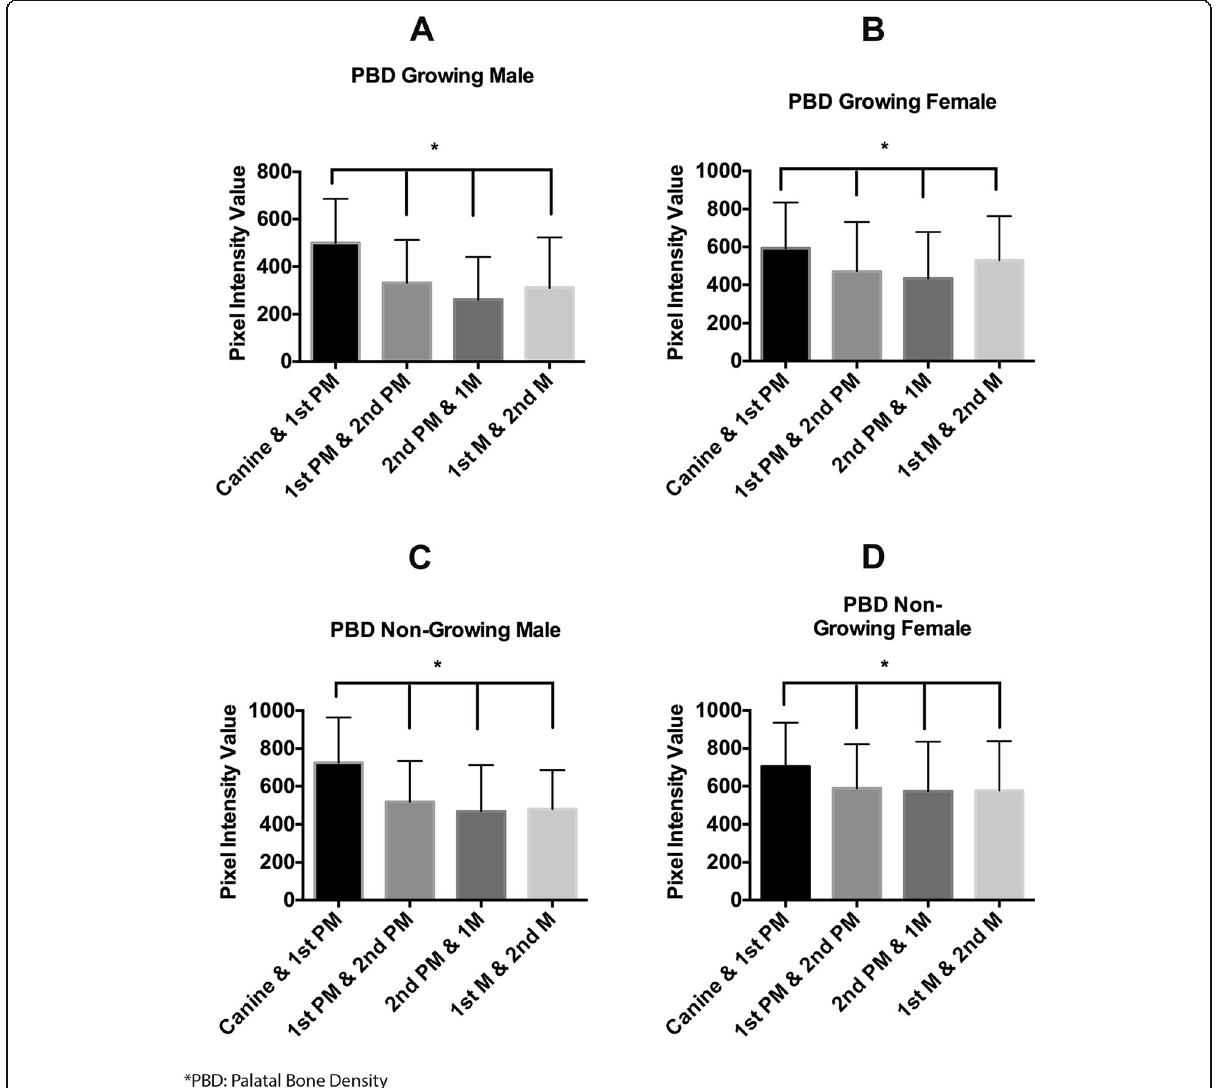
Fig. 3 Bar graph showing the palatal bone density among different groups in the center of palate. a Palatal bone density in growing male at four different points measured. b Palatal bone density in growing female at four different points measured. c Palatal bone density in non-growing male at four different points measured. d Palatal bone density in non-growing female at four different points measured. Asterisk depicts that palatal bone density is significantly more in between the canine and first premolar when compared to other three sites